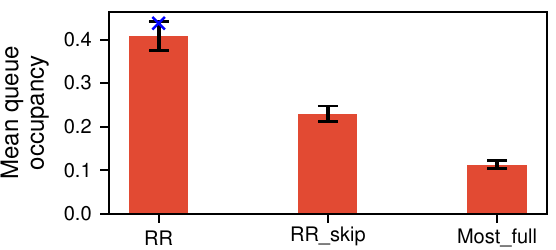
Figure 23. Mean queue occupancy for each scheduler design. Error bars are at the 99% confidence level. RR is the round-robin scheduler. RR_skip is the round-robin skip scheduler. Furthermore, Most_full is the capacity prioritization scheduler. The blue × is the predicted mean queue occupancy by the analytical